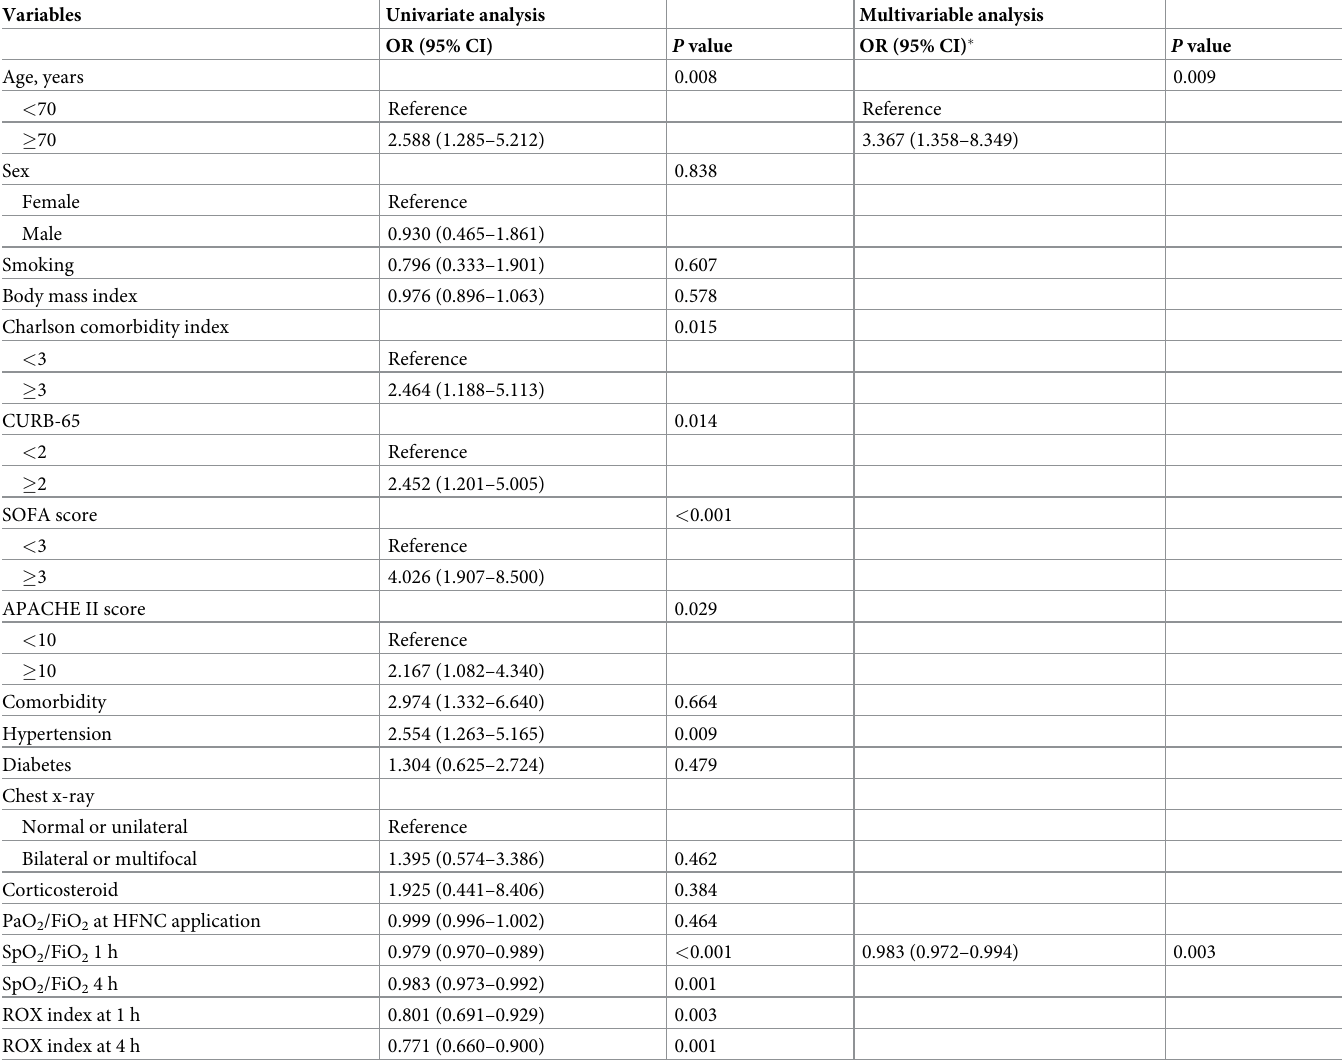
Table 2. Univariate and multivariable analyses of the predictive factors for HFNC